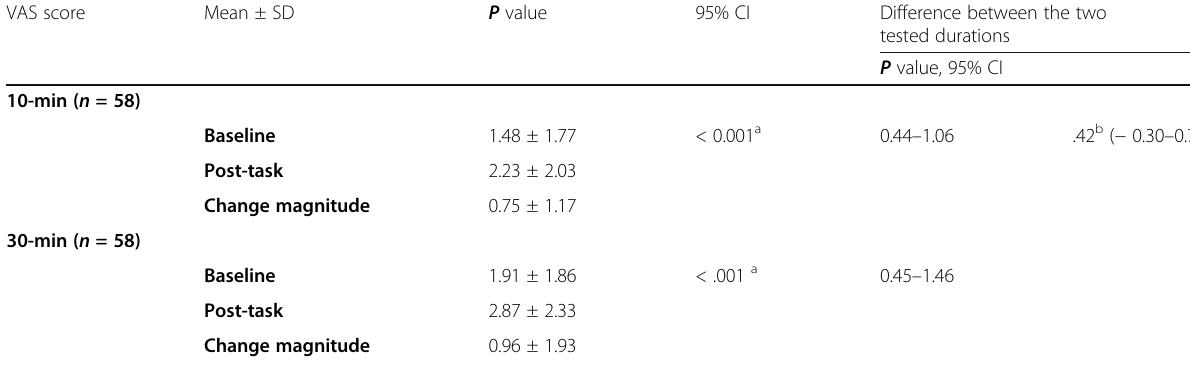
Table 2 Pain severity as measured by the visual analog scale (VAS) score